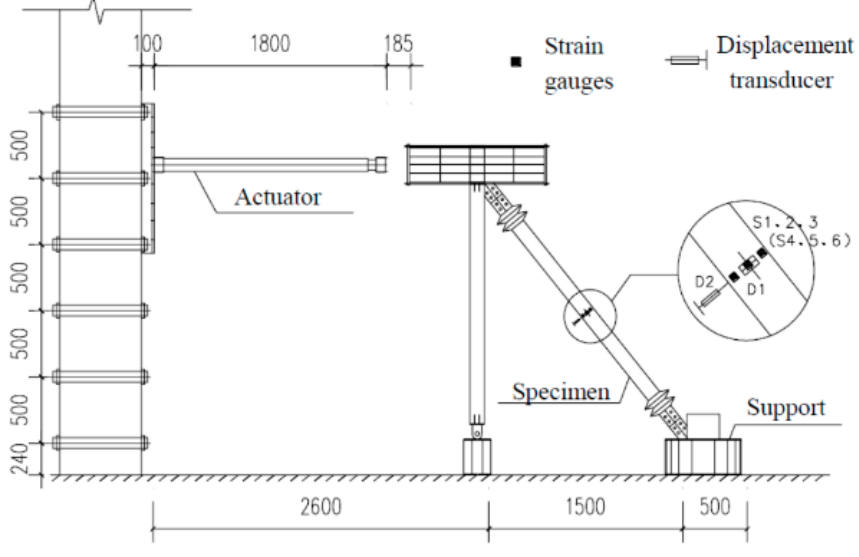
Figure 6. Test device.